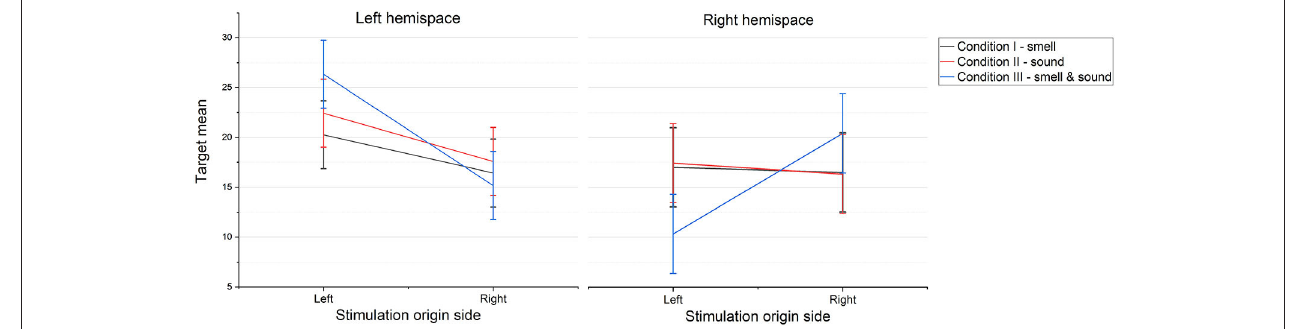
FIGURE 6 | Mean score of the participants during visuospatial exploration task on the left and right hemispaces under the three experimental conditions for the two origin sides (left or right) of the sensory stimulation. Error bars represent the standard errors of the